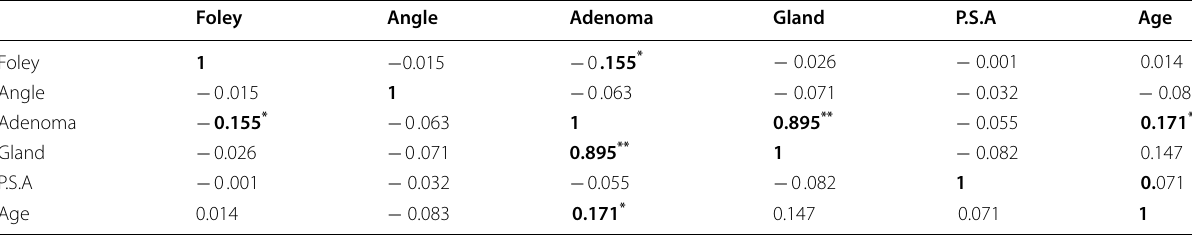
*Correlation is significant at the 0.05 level (2-tailed) **Correlation is significant at the 0.01 level (2-tailed)